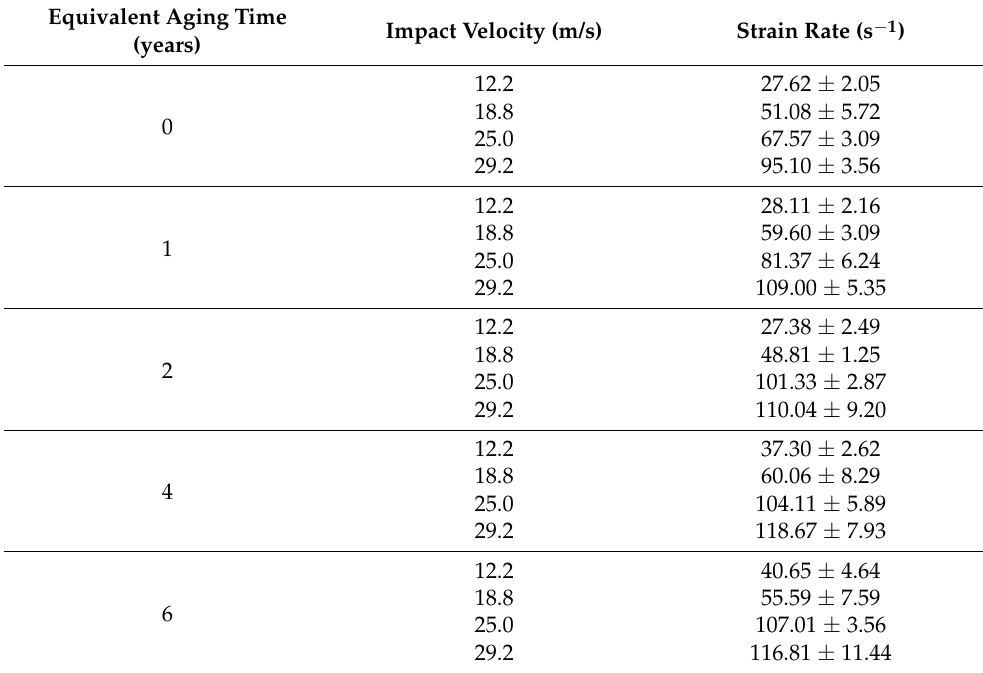
Table 4. The strain rate under different impact velocity and equivalent aging